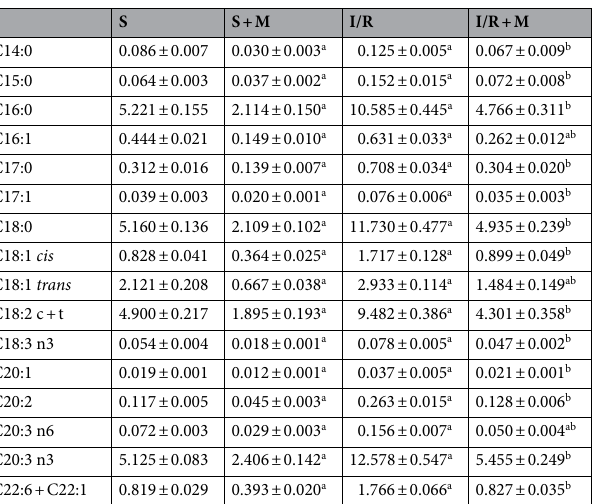
Table 2. Hepatic fatty acids concentration (µg/mg tissue). Experimental group abbreviations: S sham-operated rat group, S + M sham-operated + meldonium rat group, I/R ischemia/reperfusion rat group, I/R + M ischemia/ reperfusion + meldonium rat group. The number of animals per experimental group: n = 8. The data are given as mean ± standard error of the mean. Minimal significant level: p < 0.05. Significantly different: a in respect to S group; b in respect to I/R